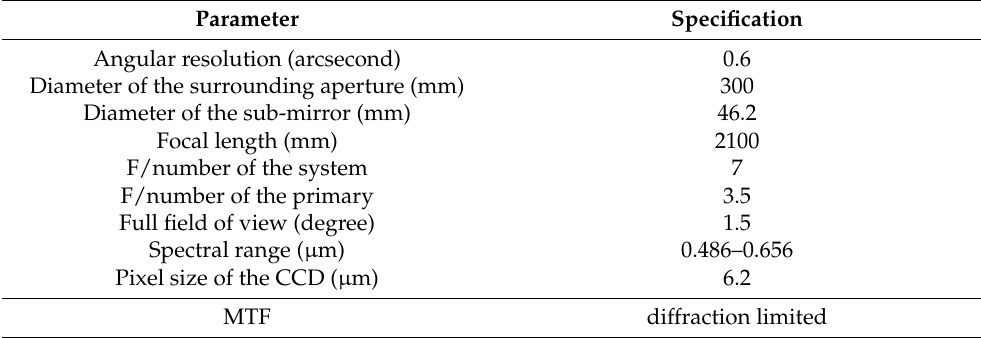
Table 1. The parameters of the Golay3 MMT.